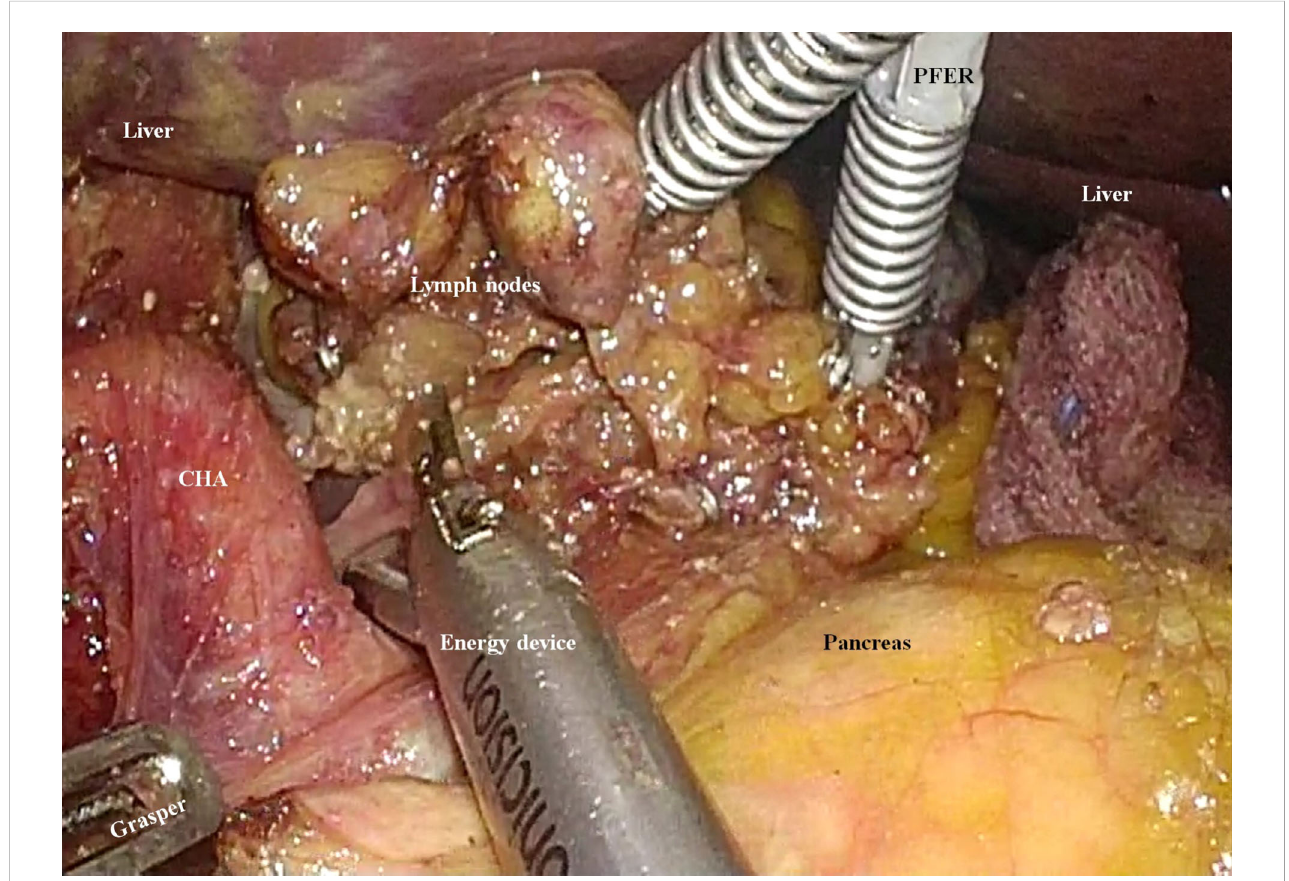
FIGURE 4 An instrument for enhancing the surgical fi eld during single-port laparoscopic gastrectomy. The EndoGrab ™ Port-Free Endocavity Retractor (Virtual Ports, Misgav, Israel) provides stable counter-traction without making any additional incisions (CHA, common hepatic artery; PFER, Port-Free Endocavity